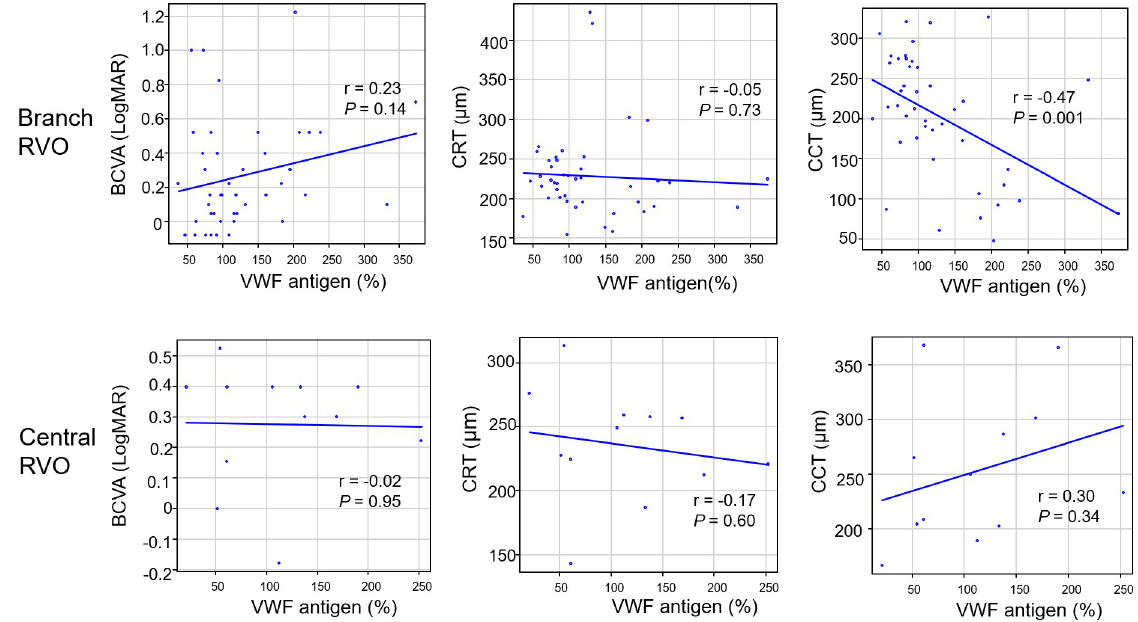
Fig 2. Correlations between VWF antigen and parameters (BCVA, CRT, and CCT) at 1 month after anti-VEGF treatment. In each graph, the horizontal axis presents the VWF antigen (%). BCVA, best-corrected visual acuity (LogMAR unit); CRT, central retinal thickness; CCT, central choroidal thickness; RVO, retinal vein